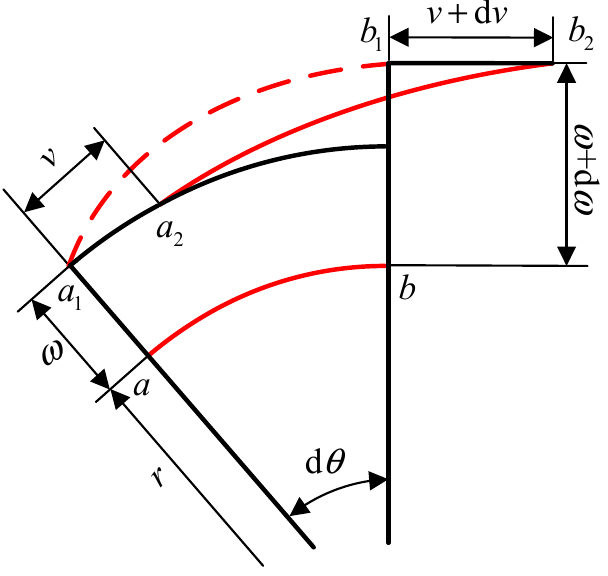
Figure 11. Deformation of the flexible wheel neutral layer line element.